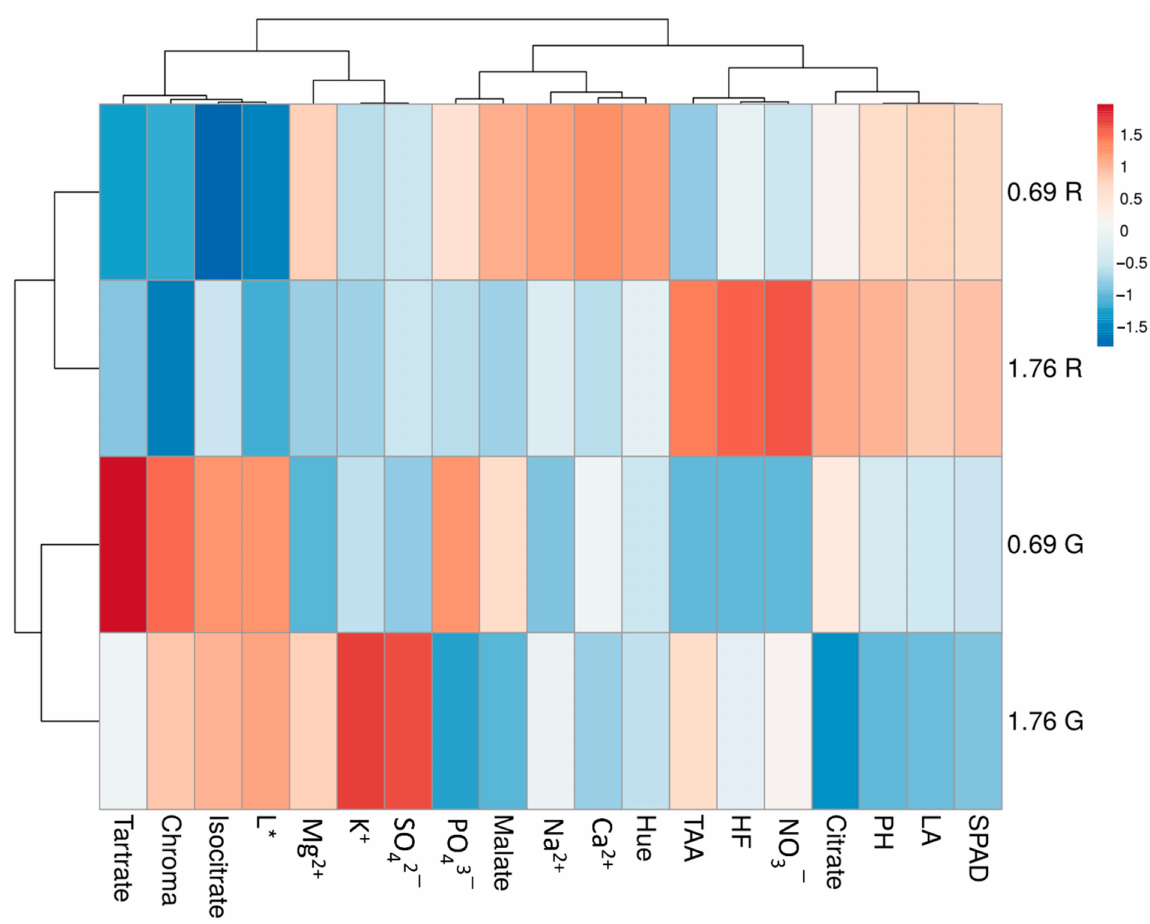
Figure 2. Heat map of qualitative and physiological aspects of green (G) and red (R) lettuce plants grown under the two VPD levels (0.69 and 1.76